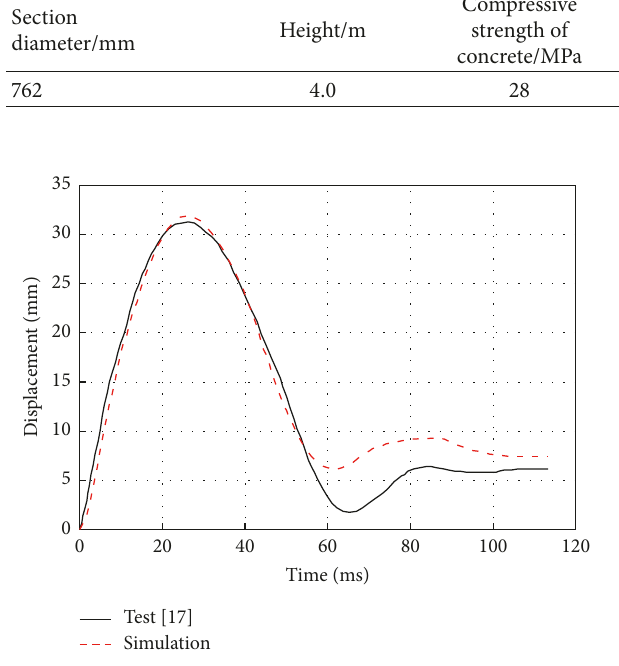
Figure 8: Comparison of midspan displacement between test and numerical result.